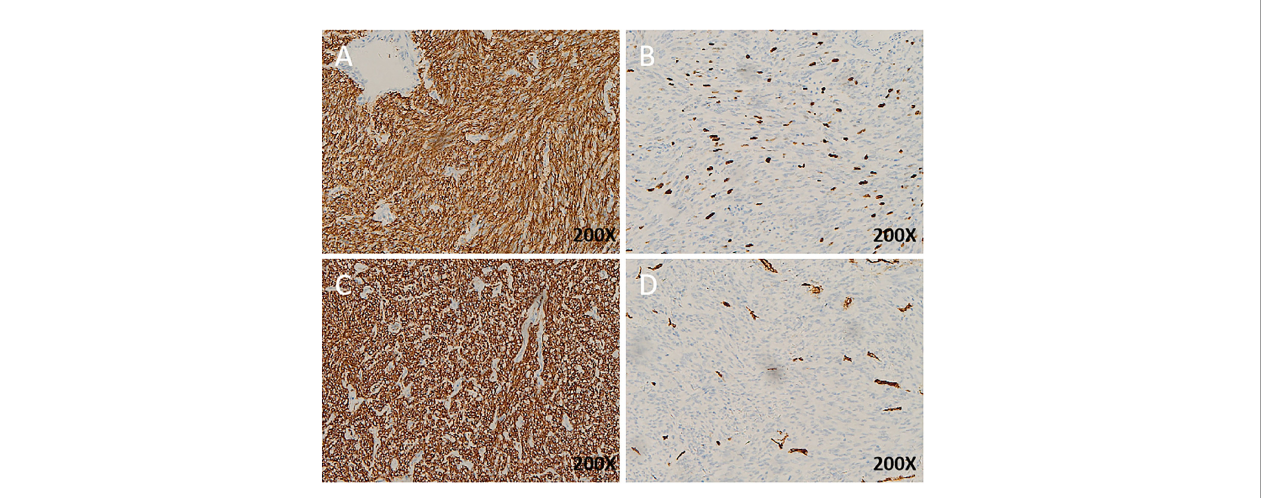
FIGURE 3 Immunohistochemistry (IHC) of EGIST: (A) , KI67 expression in EGIST; (B) , DOG1 expression in EGIST; (C) , cd34 expression in EGIST; (D) , CD117 expression in EGIST. All images with hematoxylin and eosin counterstain and ×200 magni fi cation.